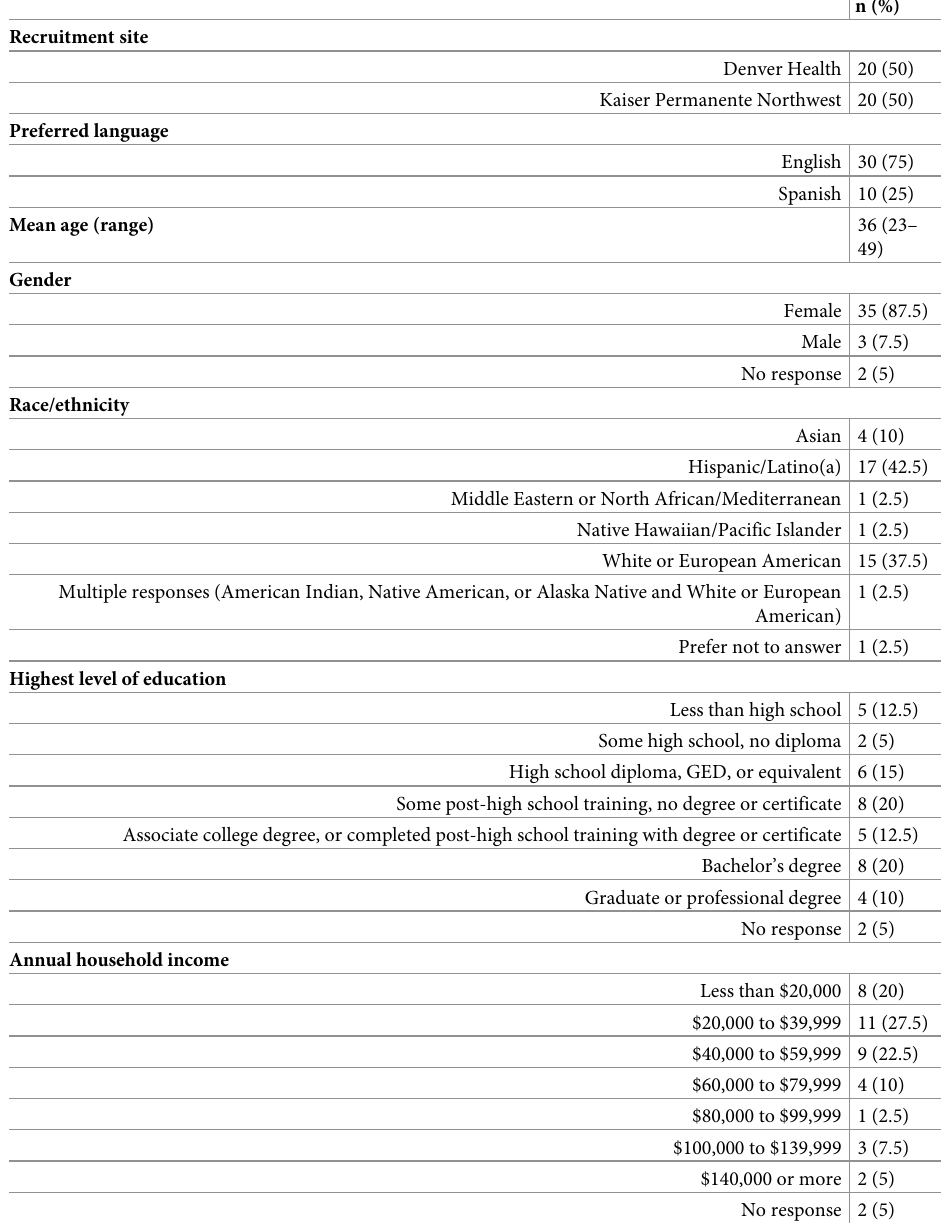
Table 2. Interviewee characteristics (n =